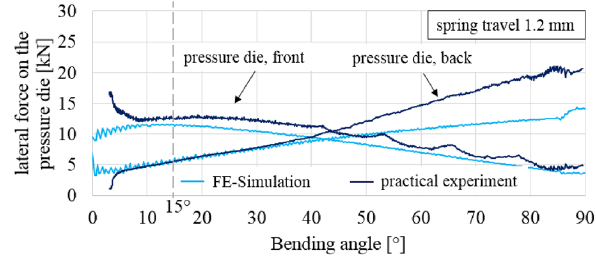
Fig. 22 Pressure die forces in FE simulation and practical